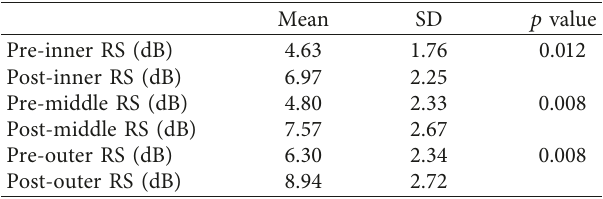
Table 1: The preoperative and postoperative values of the inner, middle, and outer rings of the retinal sensitivity at microperimetry in Group A.